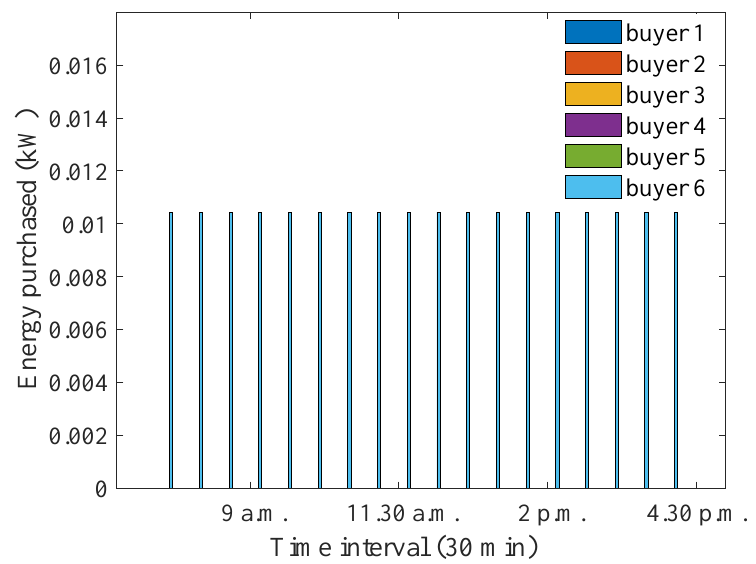
Figure 32. Optimum energy purchased for equally preferred sellers and buyers when profit threshold is increased to a larger